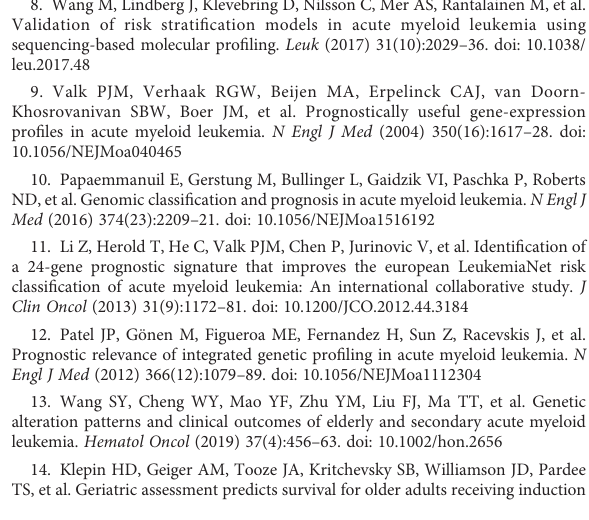
SUPPLEMENTARY FIGURE 4 Overall survival analysis in AML patients with TP53 mutated or complex karyotype included in the PETHEMA-FLUGAZA trial using the expression of B7H3 and BANP genes according to their treatment arm. (A) AZA arm. (B) FLUGA arm. SUPPLEMENTARY TABLE 1 Baseline characteristics of patients included in the FLUGAZA-PETHEMA clinical trial in whom RNASeq was performed. SUPPLEMENTARY TABLE 2 Gene ontology pathways and biological processes associated with the 15 differentially expressed genes with survival impact on the univariate analysis in mutated TP53 or complex karyotype groups. SUPPLEMENTARY TABLE 3 Baseline characteristics of 51 patients of the cohort with the selected genetic signature according to the obtained prognosis